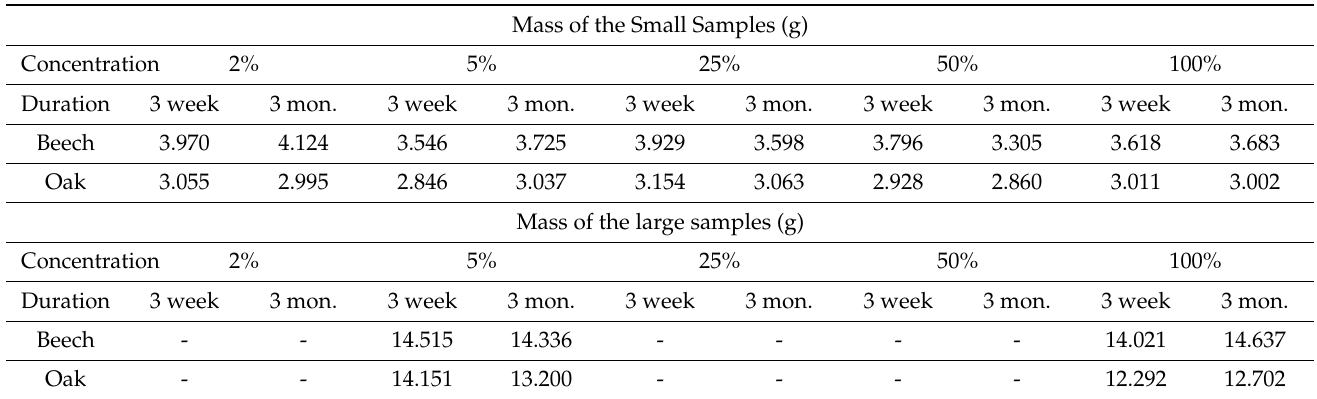
Table 3. Initial mass of the samples regarding each test condition.